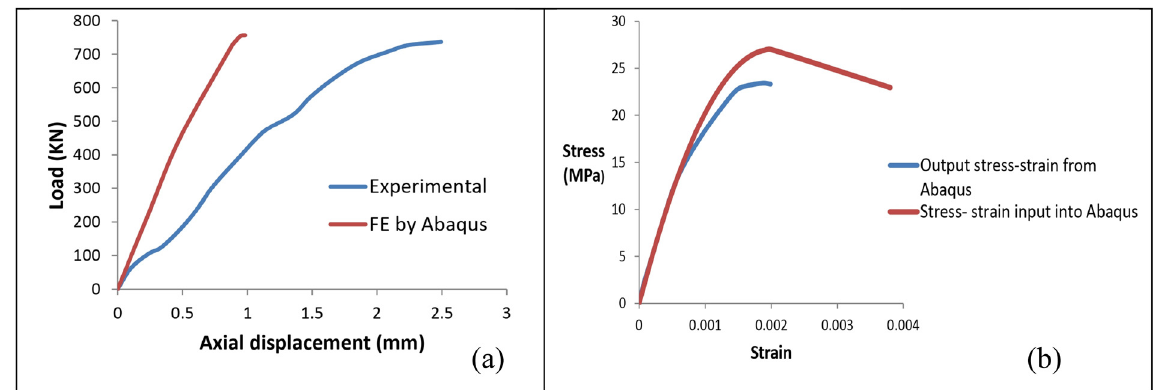
Figure 12: ( a ) Load versus axial displacement and ( b ) input and output stress – strain diagrams.